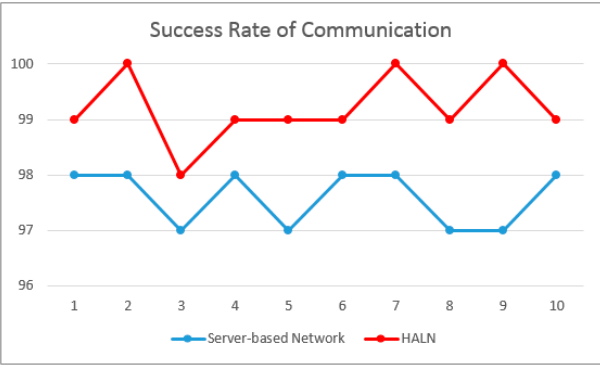
Electronics 2020 , 9 , x FOR PEER REVIEW Figure 11. Comparison of communication success rates. Figure 11. Comparison of communication success rates.